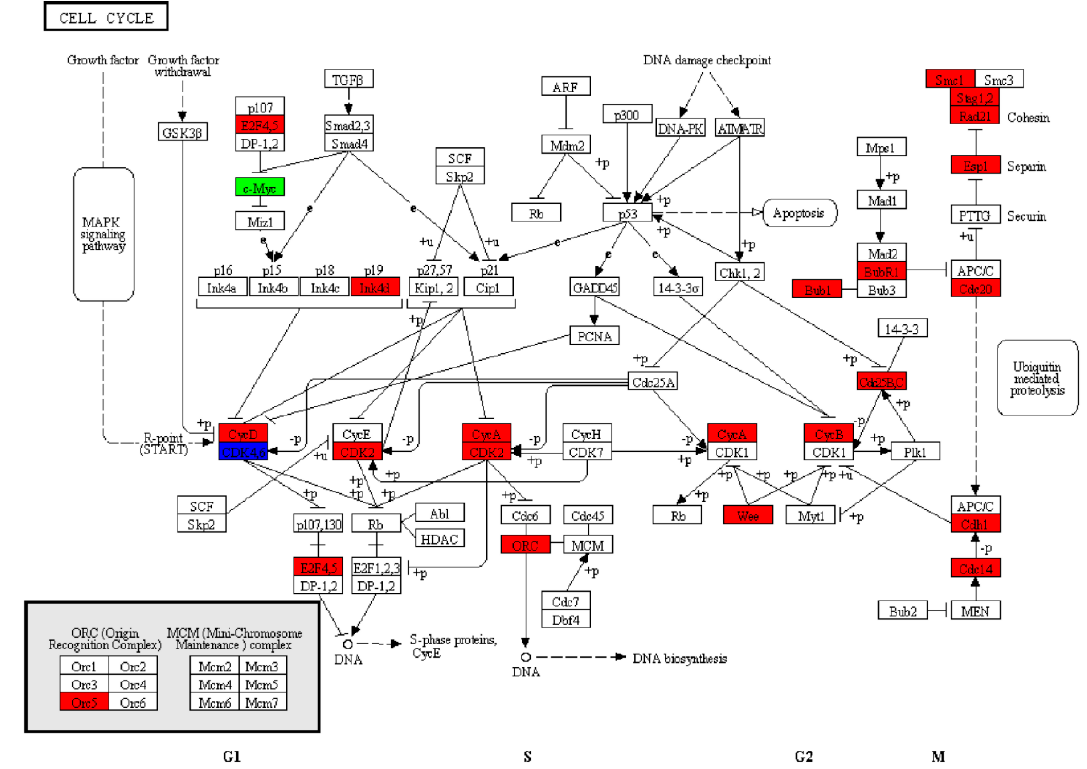
Figure 11. Cell cycle pathway. Green, significantly decreased expression; blue, proteins encoded by both up- and downregulated genes; red, significantly increased expression.